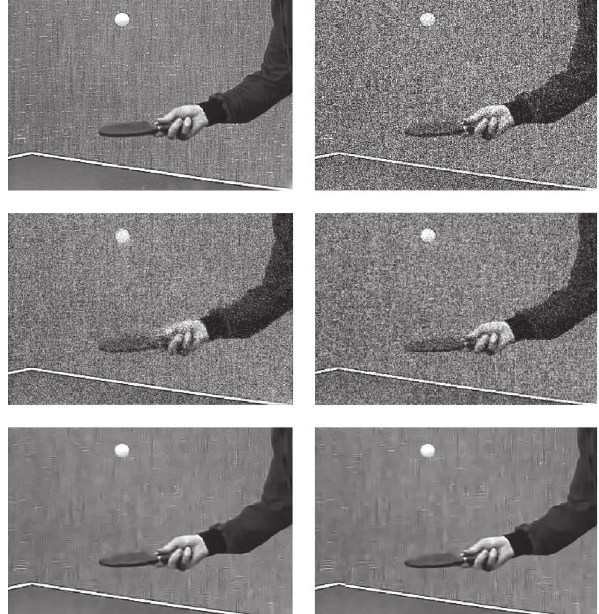
Figure 3: Visual comparison of different algorithms for frame 5 of Tennis sequence. From left to right and from top to bottom: original frame, noisy frame ( 𝜎 𝑛 = 40 ), result of [18] algorithm, result of [19] algorithm, result of [13] algorithm, and result of the proposed